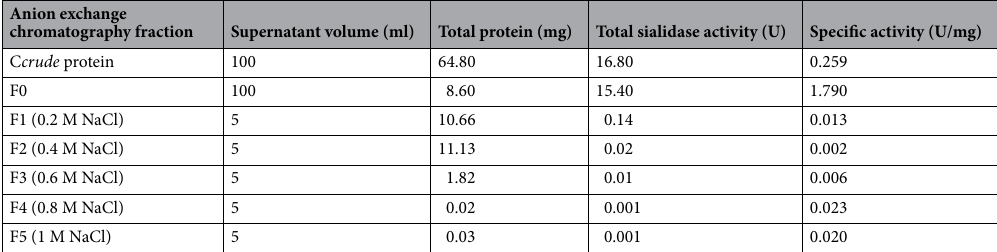
Table 5. Results of purification of NanB sialidase by anion exchange chromatography.